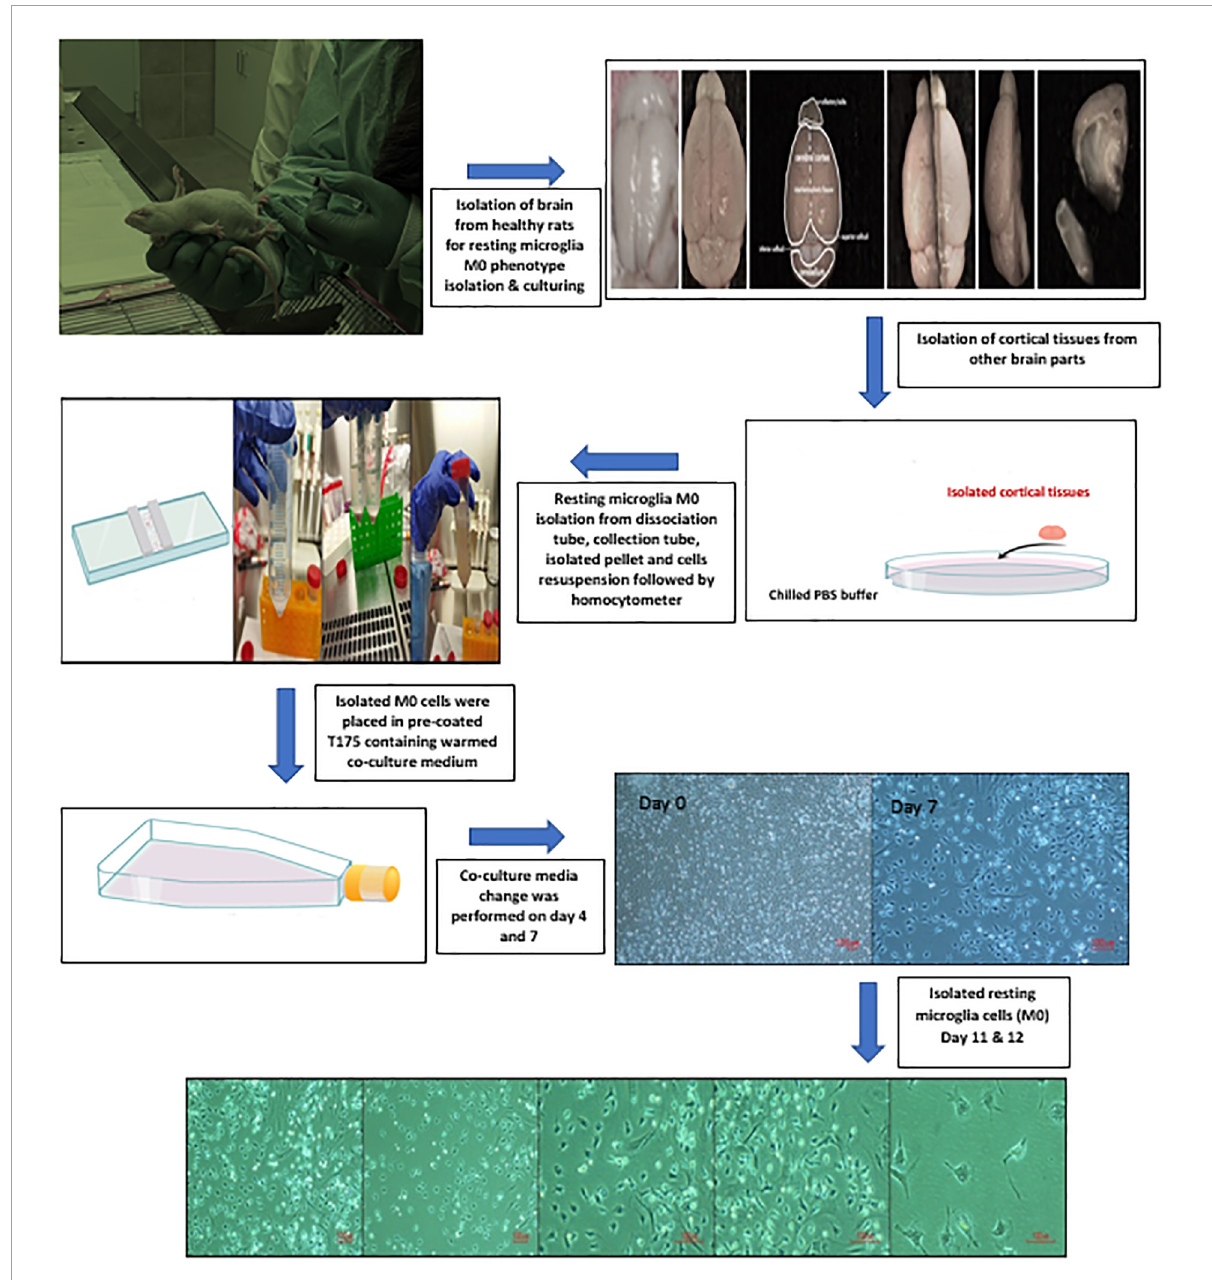
FIGURE1 Illustration of primary healthy microglia (PHM) isolation steps and light microscopy images of cultured PHM after 11 and 12 days.